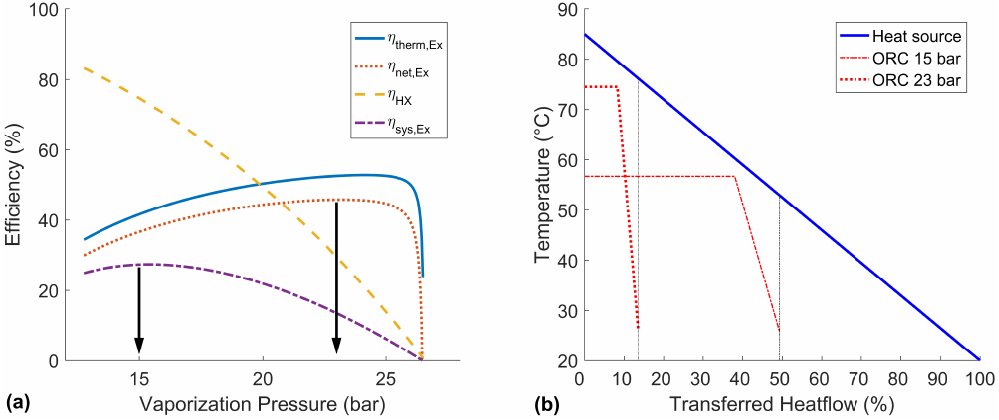
Figure 5. Performance of an ORC with the given heat source: ( a ) influence of the vapor pressure on the efficiency; ( b ) T-Q-diagram of two characteristic operating